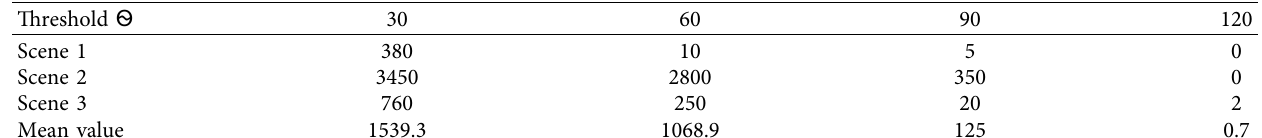
Table 1: Number of noise pixels under different